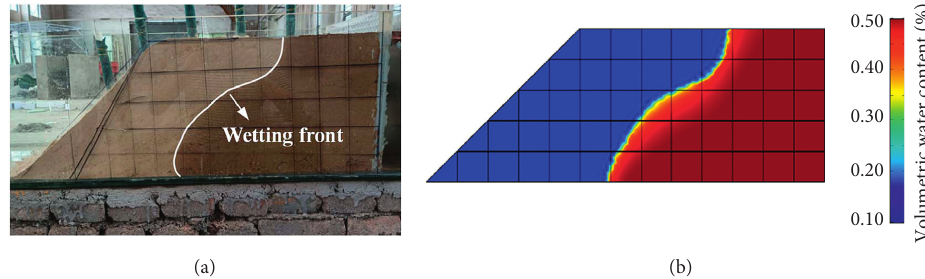
Figure 11: Observed and simulated water flow processes in the rare earth pile. (a) Wetting front observed in the laboratory test. (b) Water content obtained by the COMSOL